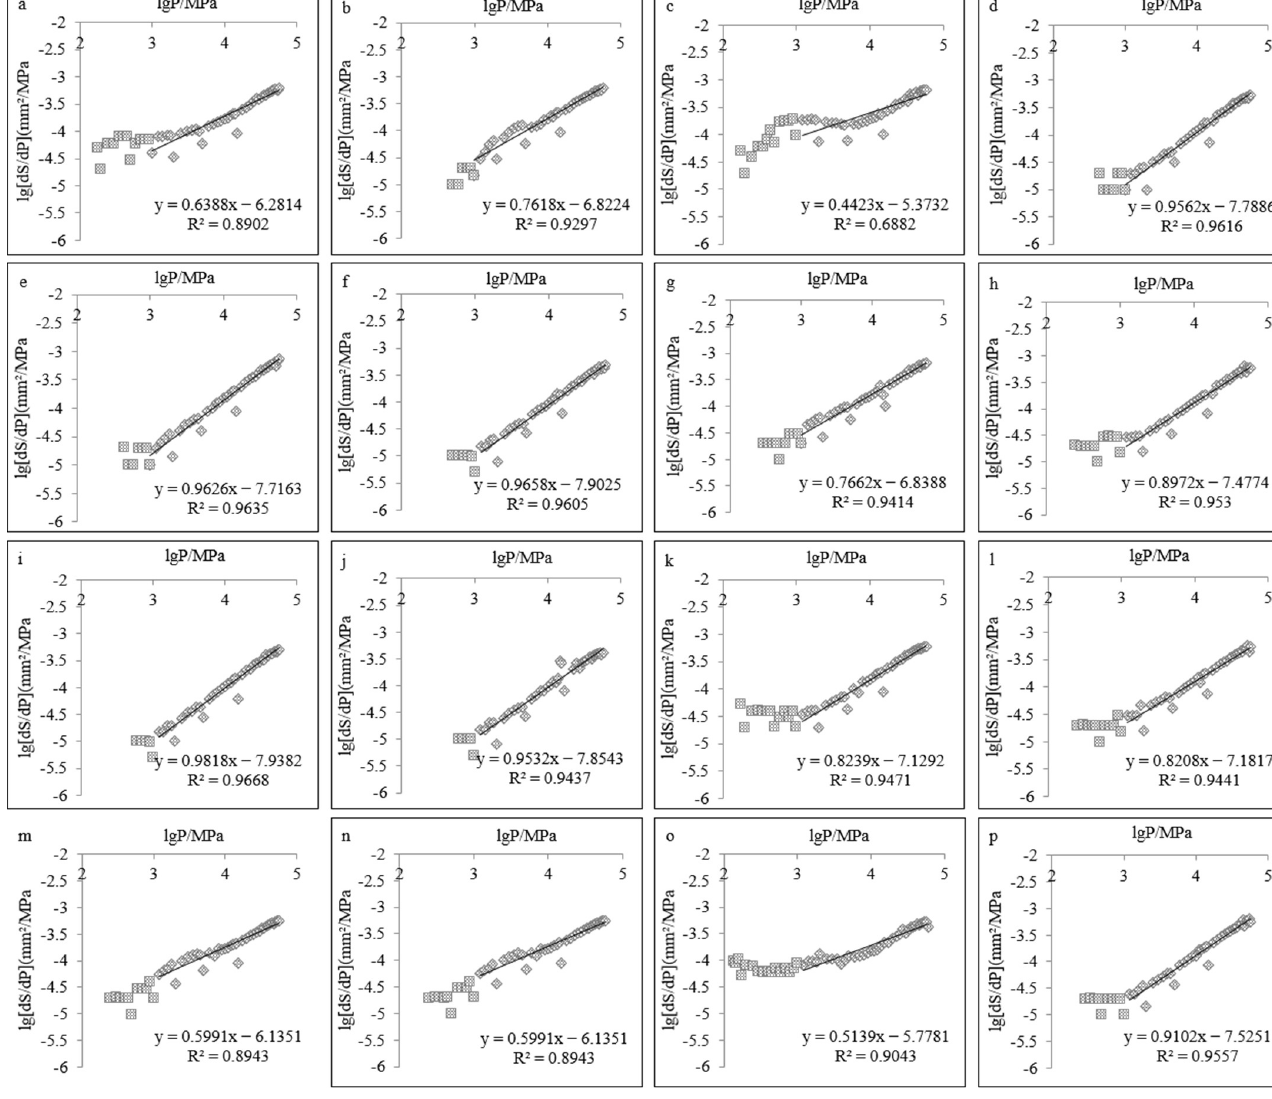
Figure 6. Plots (a-t) of the volume increment in fixed stress ( dV/dP ) and pressure ( P ) in the double logarithm coordinates corresponding to coal samples M1-M20. 5. Discussion 5.1. The Structural Characteristics and Natural Classification of Pores As the fractal geometry theory has pointed out, the more homogeneously distributed the pores are, the bigger the fractal dimension [62]. In the first line segment, all prepared samples similarly exhibited that the structure of pores with a diameter of over 65 nm was extremely complicated because the fractal dimension was closed to three, whereas the